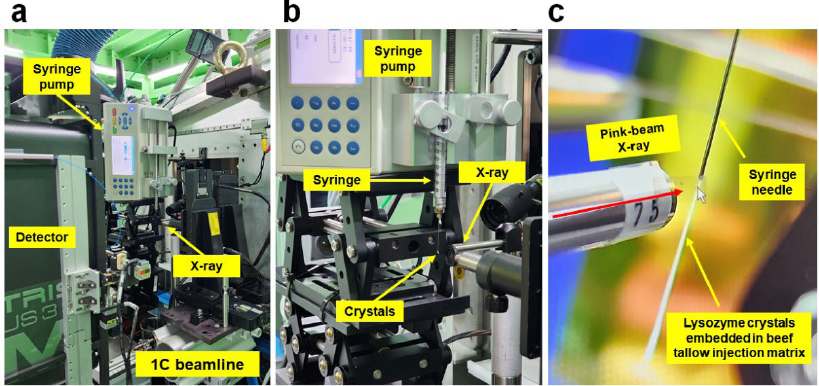
Figure 1. Experimental setup and sample injection for pink-beam serial crystallography. ( a ) Experimental setup of pink-beam serial crystallography at the 1C beamline at the PLS-II. ( b ) A close-up view of the sample environment. ( c ) Injection of lysozyme crystal embedded in the beef tallow injection matrix. The X-ray position is denoted by the white arrow.